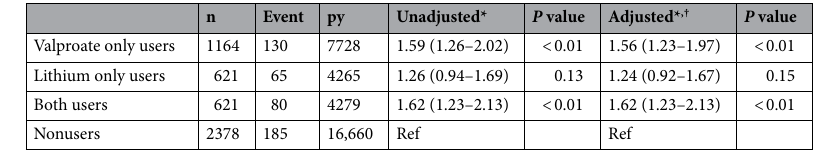
Table 2. Risk of dementia in valproate only users, lithium only users, and both valproate and lithium users compared to nonusers. py, person-years. *Hazard ratio for dementia with 95% confidence intervals estimated by multivariable Cox proportional hazard models. † Adjusted for diabetes, alcohol-related disorder, and use of antiepileptics.